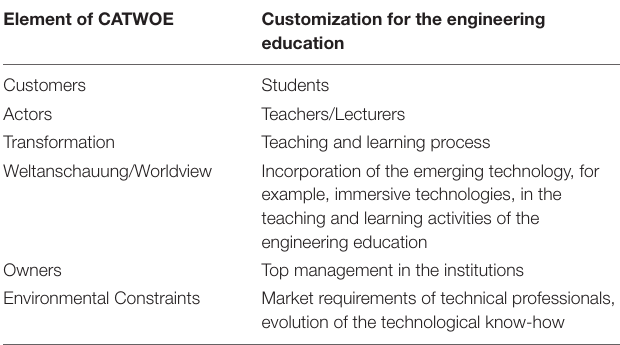
TABLE 1 | Elements of CATWOE for engineering education. Element of CATWOE Customization for the engineering